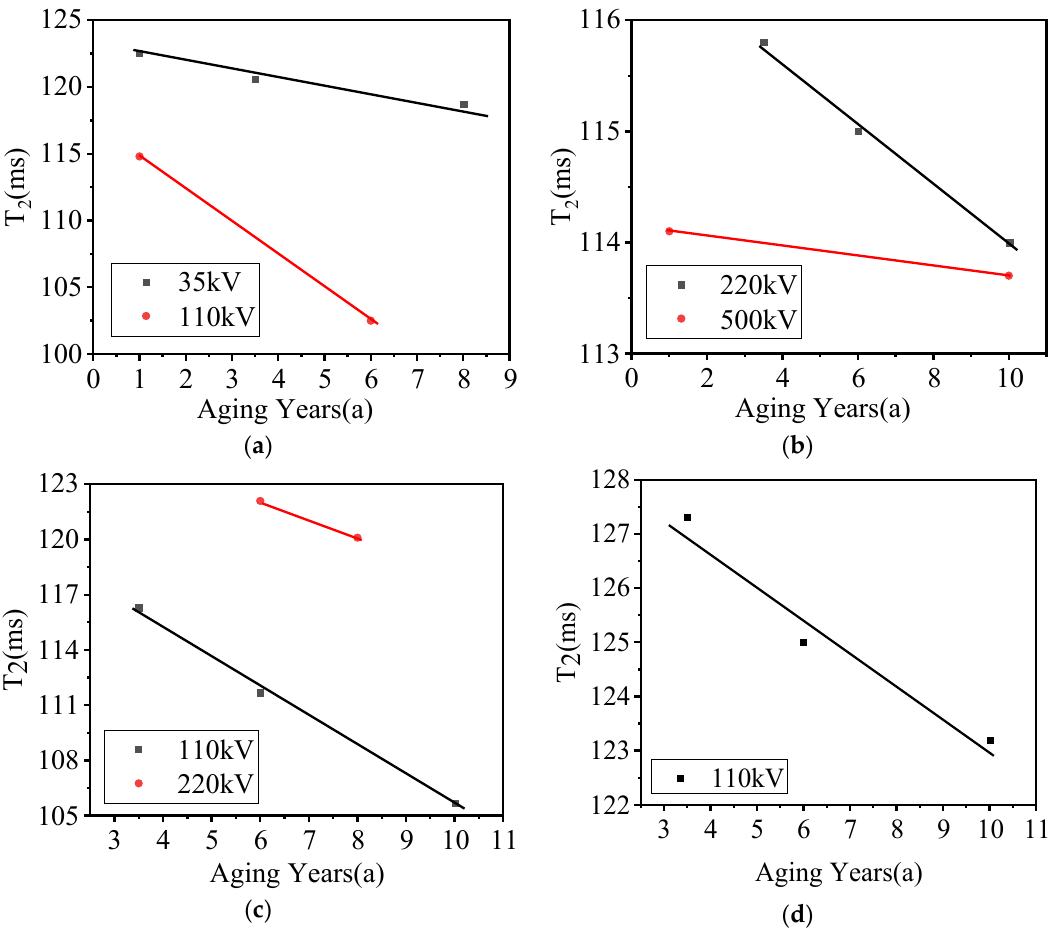
Figure 8. Variation of T 2 with years of aging: ( a ) Factory A, ( b ) factory B, ( c ) factory C, ( d ) factory D.